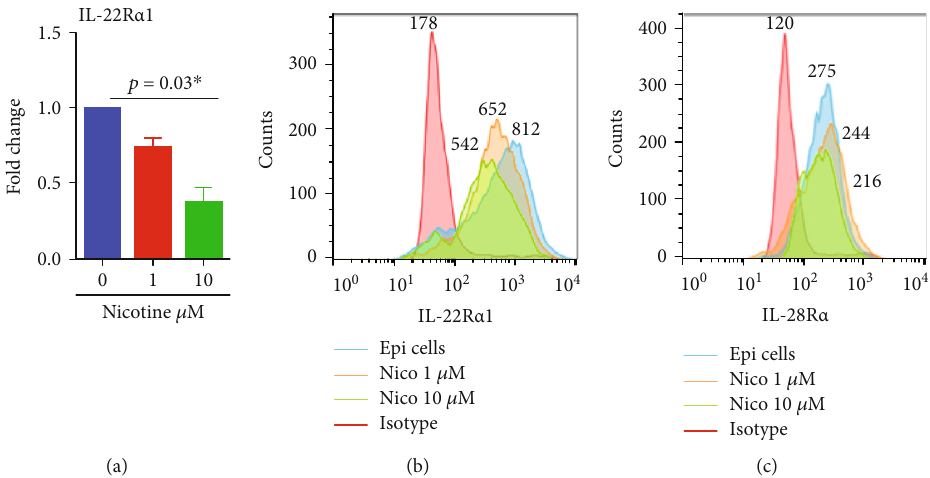
Figure 3: Downregulation of IL-22R expression on AECs by nicotine. Primary human AECs were exposed to nicotine 1-10 μ M for 72h. The expression of IL-22R α 1 as determined by (a) q-PCR. ∗ indicates that p value is signi fi cant. (b) Flow cytometry. (c) Expression of IL-28r α by fl ow cytometry. Data is representative of 4 experiments with AECs from 2 di ff erent donors. Numbers on the histograms depict the MFI